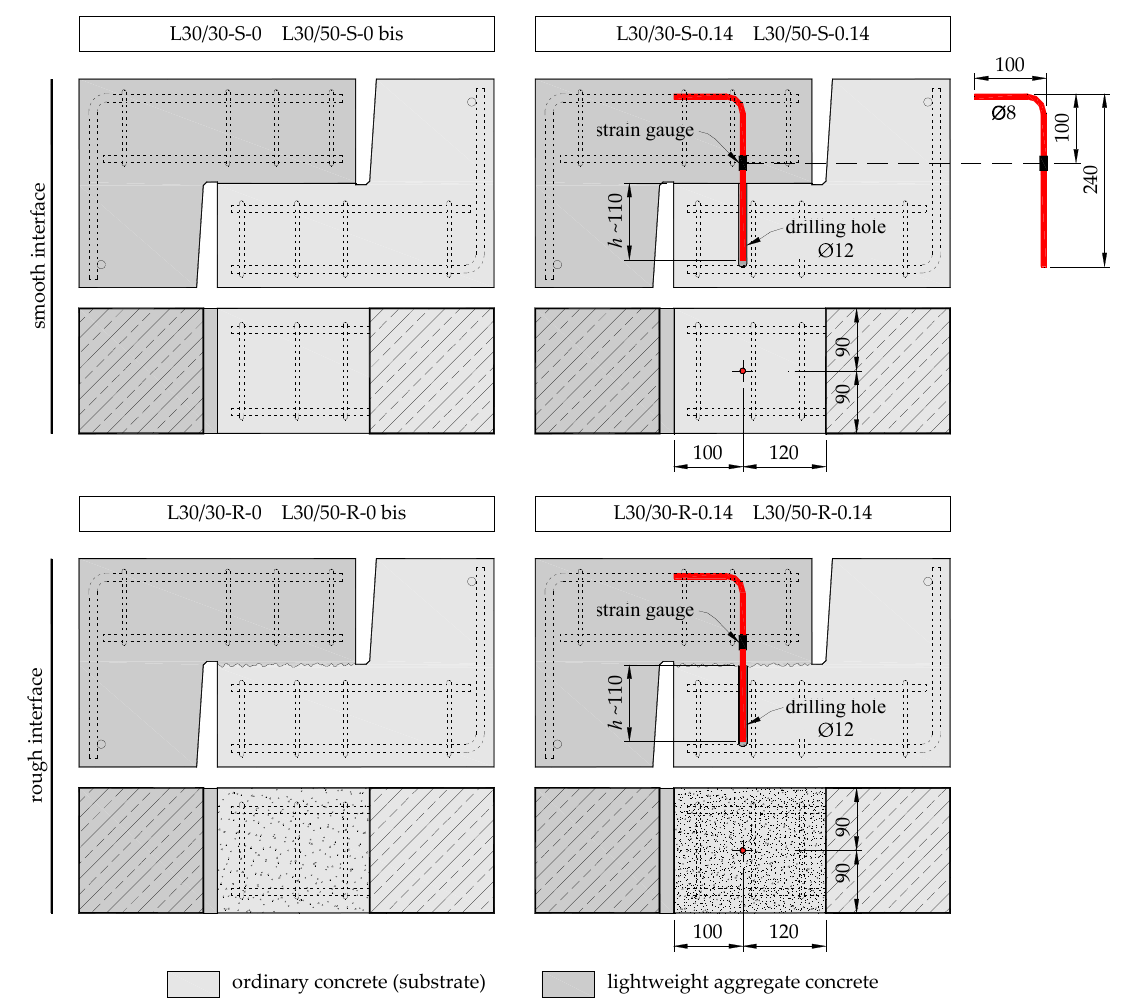
Figure 5. Details of the test specimens (all dimensions in mm).